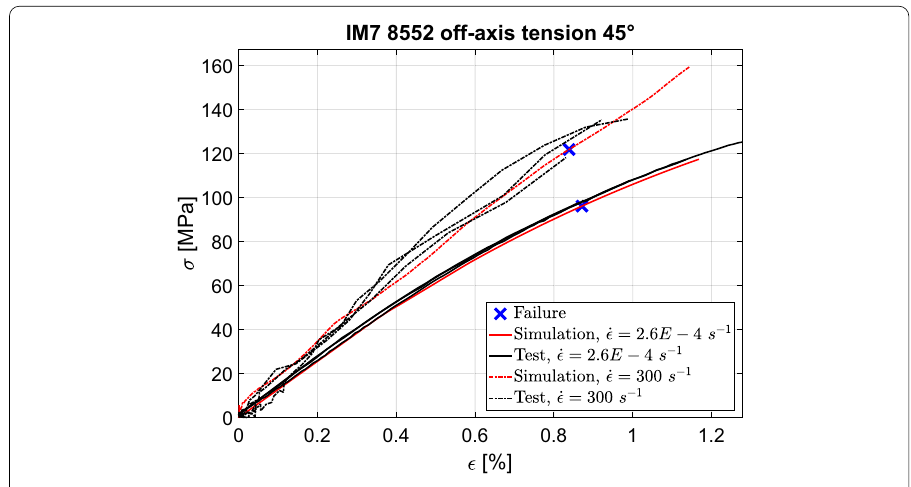
Fig. 14 True stress–true strain curves for the tensile tests and simulations, 45 ◦